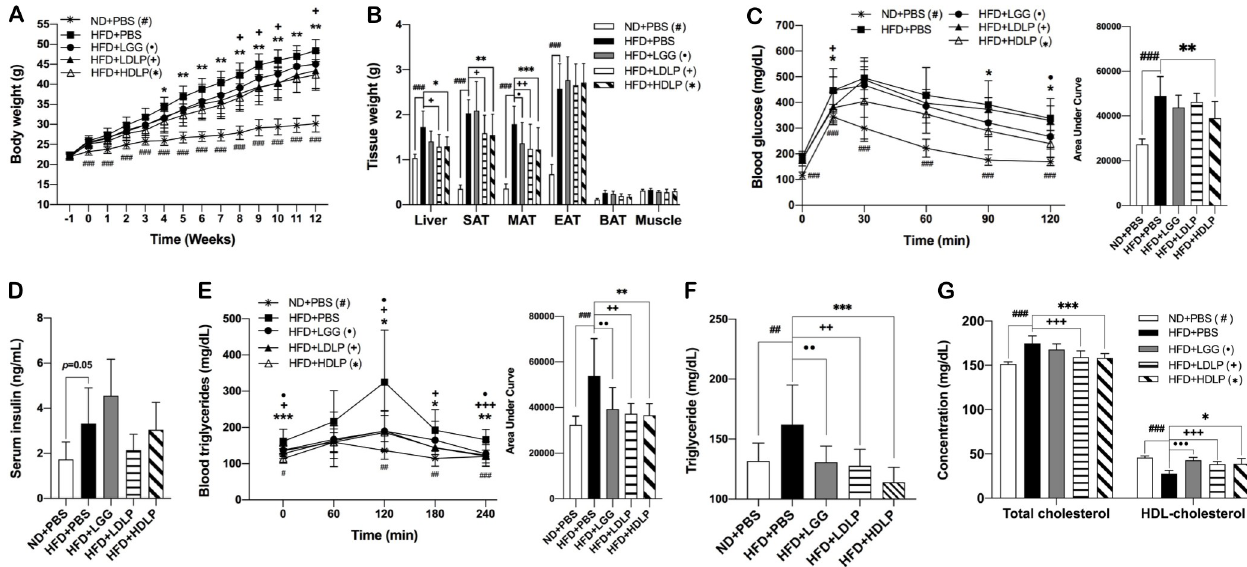
Fig 1. L . plantarum treatment reduces adiposity and improves glucose and lipid intolerance in HFD-fed mice. (A) Body weight changes for 13 weeks of HFD feeding with LGG or L . plantarum treatment for latter 12 weeks (n = 9–10). (B) Changes in tissue weight after 12 weeks of LGG or L . plantarum treatment (n = 9–10). (C) Serum concentration of insulin after 12 weeks of LGG or L . plantarum treatment quantified by ELISA (n = 6). (D and E) Intraperitoneal glucose tolerance test and oral lipid tolerance test in mice at 10 and 11 weeks of LGG or L . plantarum treatment, respectively (n = 9). (F and G) Blood levels of TG, total cholesterol, and HDL-cholesterol after 11 weeks of LGG or L . plantarum treatment. Statistical significance was determined using two- way ANOVA with (Fig 1A and 1B) or ordinary one-way ANOVA (Fig 1F and 1G) with Dunnett’s comparison test. #, •, +, � p < 0.0332, ##, ••, ++, �� p < 0.0021, ###, •••, +++, ��� p < 0.0002. Student’s two-tailed t-test was used for analysis of differences between experimental groups (Fig 1C, 1D, and 1E). #, •, +, � p < 0.05, ##, ••, ++,